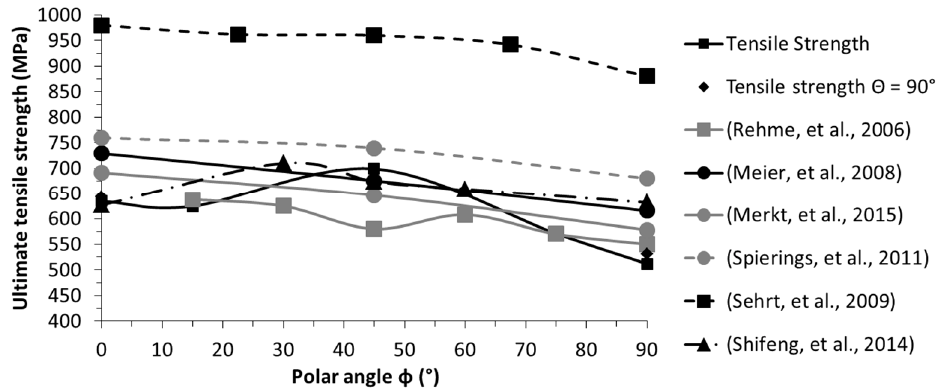
Figure 7. Orientation dependency of the ultimate tensile stress; comparison with reported results [4,14,18–20,66].